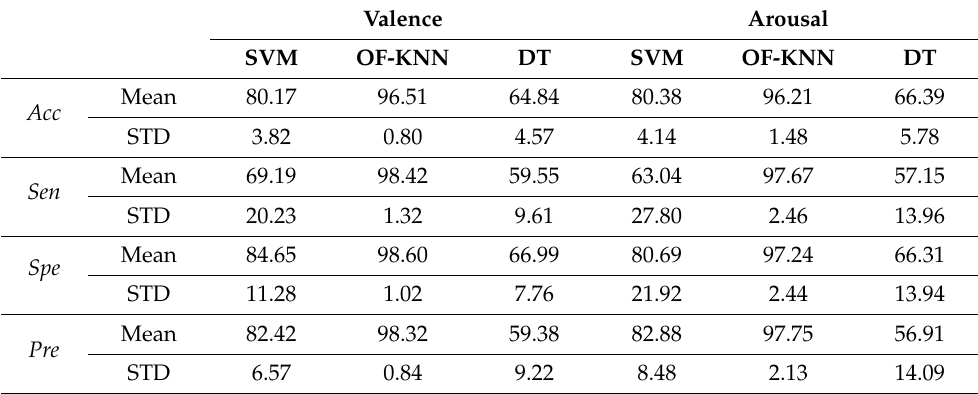
Table 3. Performance estimation for complex network features of HVG (%).